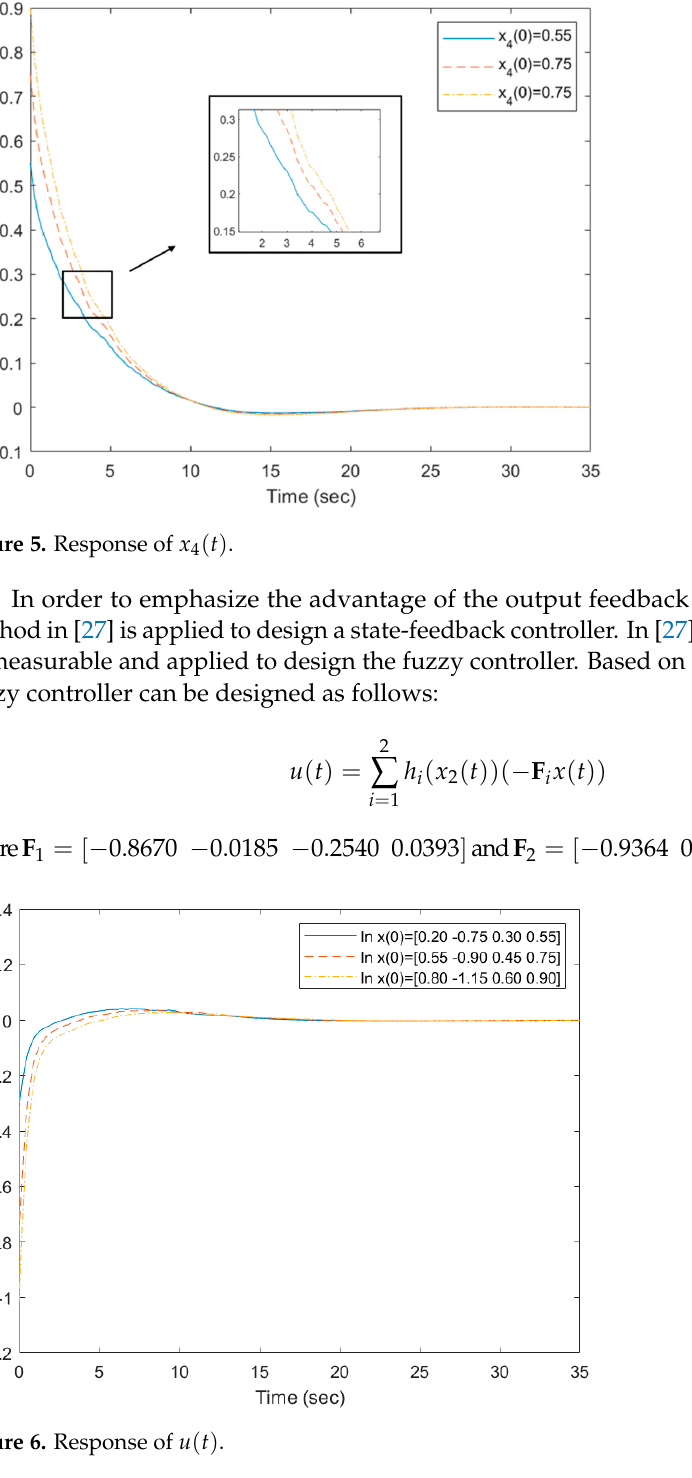
Figure 4. Response of 𝑥 (cid:2871) (cid:4666)𝑡(cid:4667) .